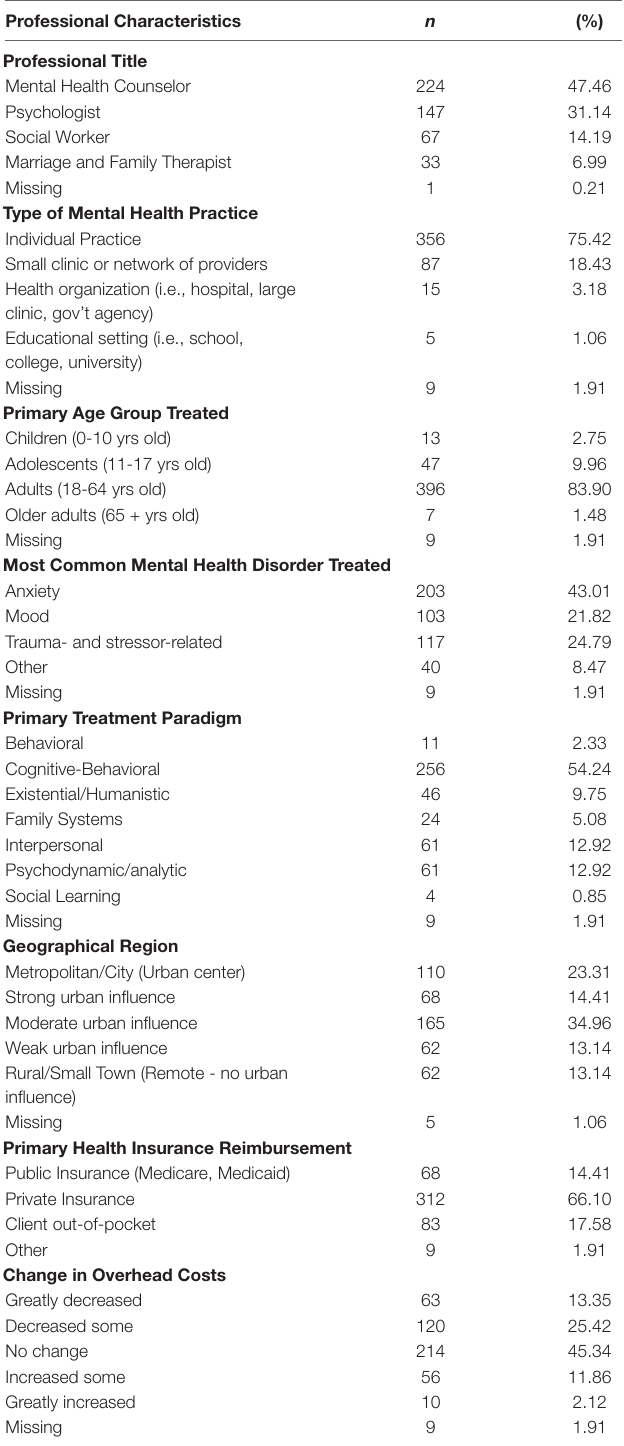
TABLE 3 | Professional characteristics of TMH providers ( N = 472). Professional